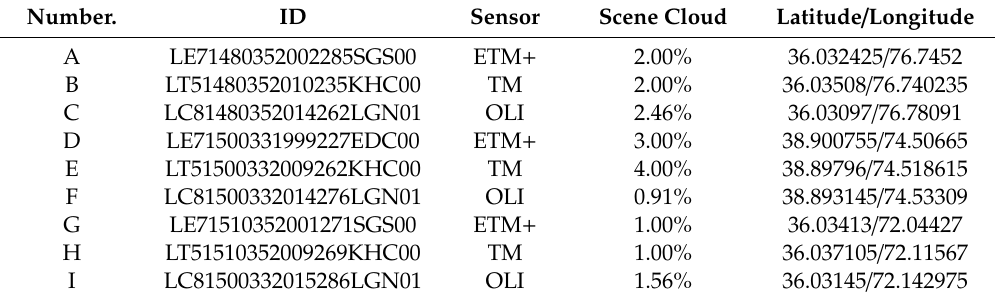
Table 1. The detailed information of the Landsat images of the tested